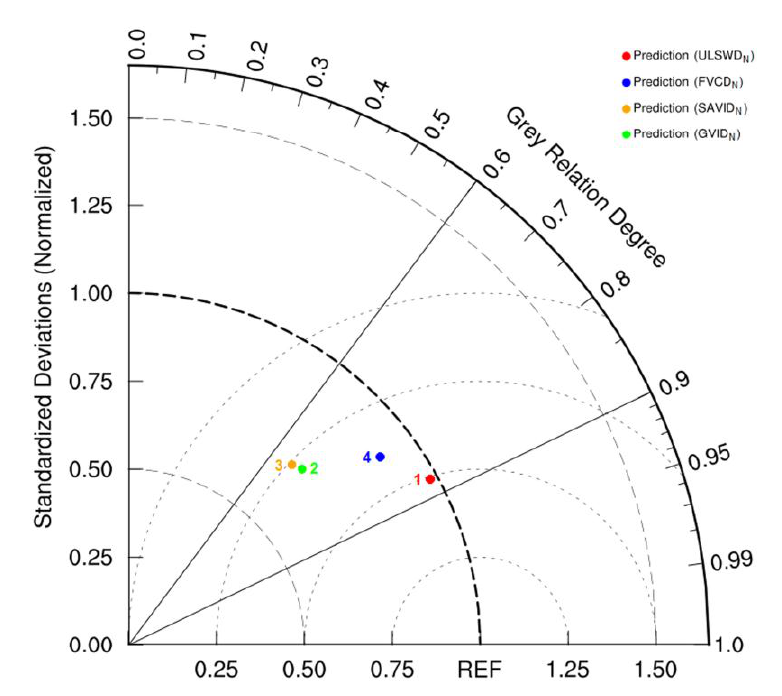
Figure 12. Performance of the predicted values calculated by four indices (the statistics in the Taylor diagram); an ideal model would have a standard deviation ratio (σ norm ) of 1.0 and a correlation coefficient of 1.0 (REF is the reference point).